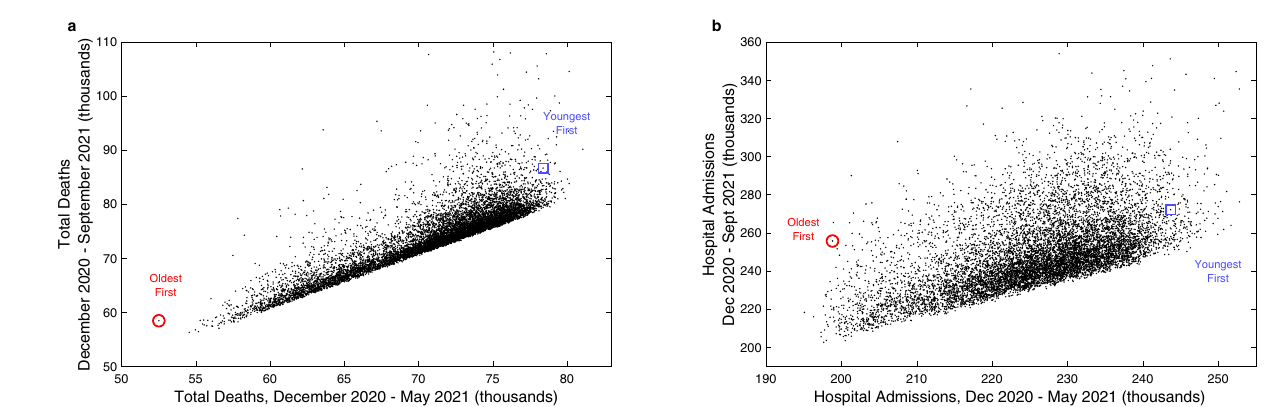
Fig. 2 | Prediction of deaths and hospital admissions for a range of age- dependent vaccination priority orders. For 10,000 randomly chosen age-based priority orders the black dots show the total expected number of deaths ( a ) and hospitaladmissions( b )overtheremainderoftheAlphawave(8thDecember2020